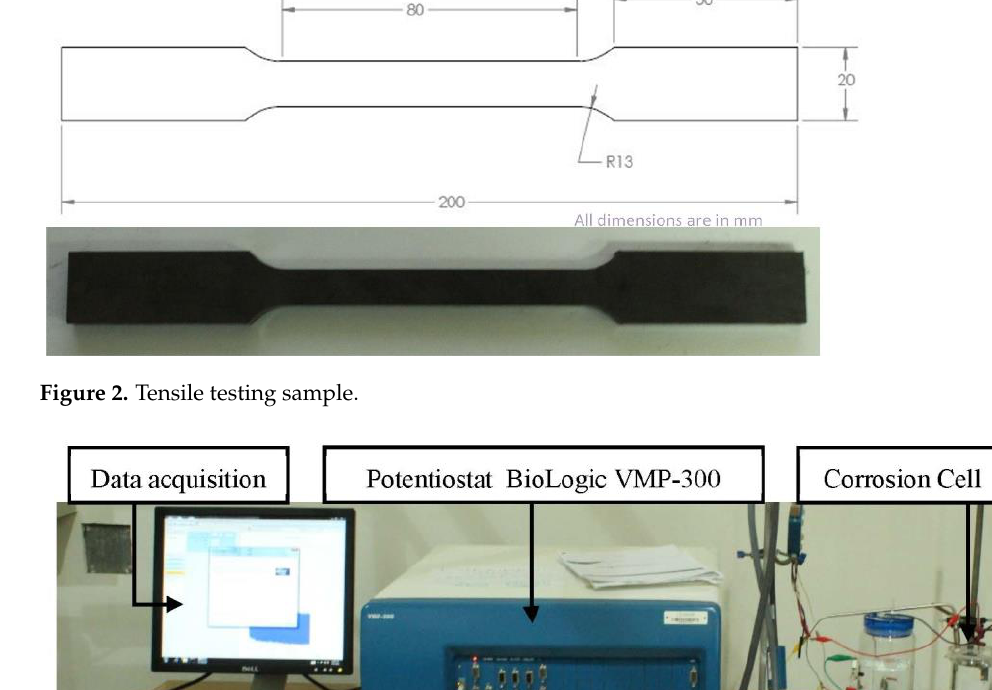
Figure 2. Tensile testing sample.